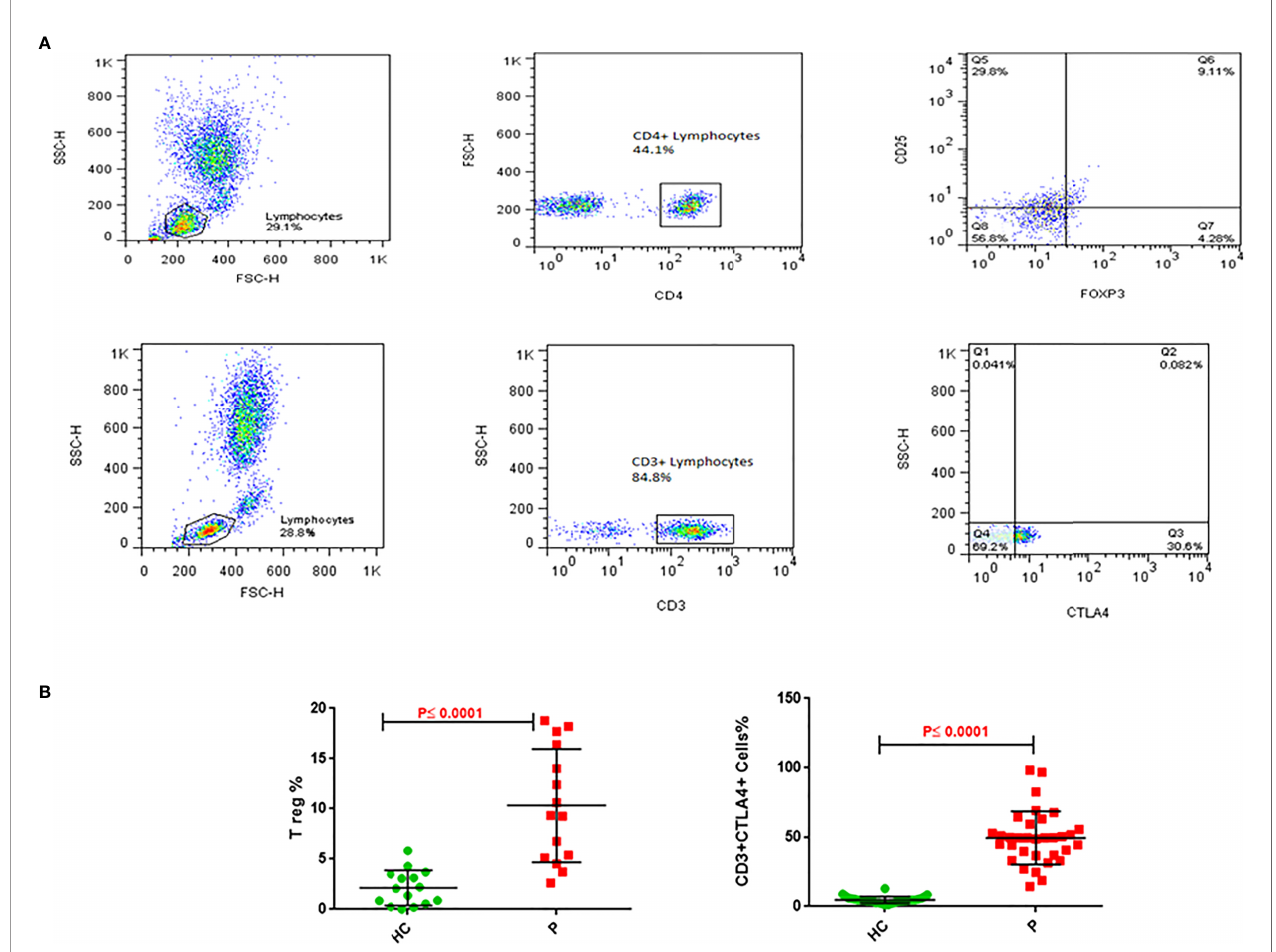
FIGURE 3 | Treg and CD3/CTLA-4 cells in blood of NSCLC patients. (A) Upper panel: Gating strategy for Treg cells frequency; analysis of a blood sample for CD25, as well as FoxP3 expression in the CD4+ lymphocyte gate. (A) Lower panel: Gating strategy for CD3+CTLA4+ cells percentage. Analysis of a blood sample for CTLA4 expression in the CD3+ lymphocyte gate. (B) Flow cytometry analysis of frequencies Treg and CD3/CTLA-4 in blood cells stained with related antibodies of NSCLC and healthy control subjects, which was calculated statistically and plotted to the graph (P ≤ 0.0001). The dots indicate the means, and the error bars indicate the standard deviations of all patients and healthy control measurements.